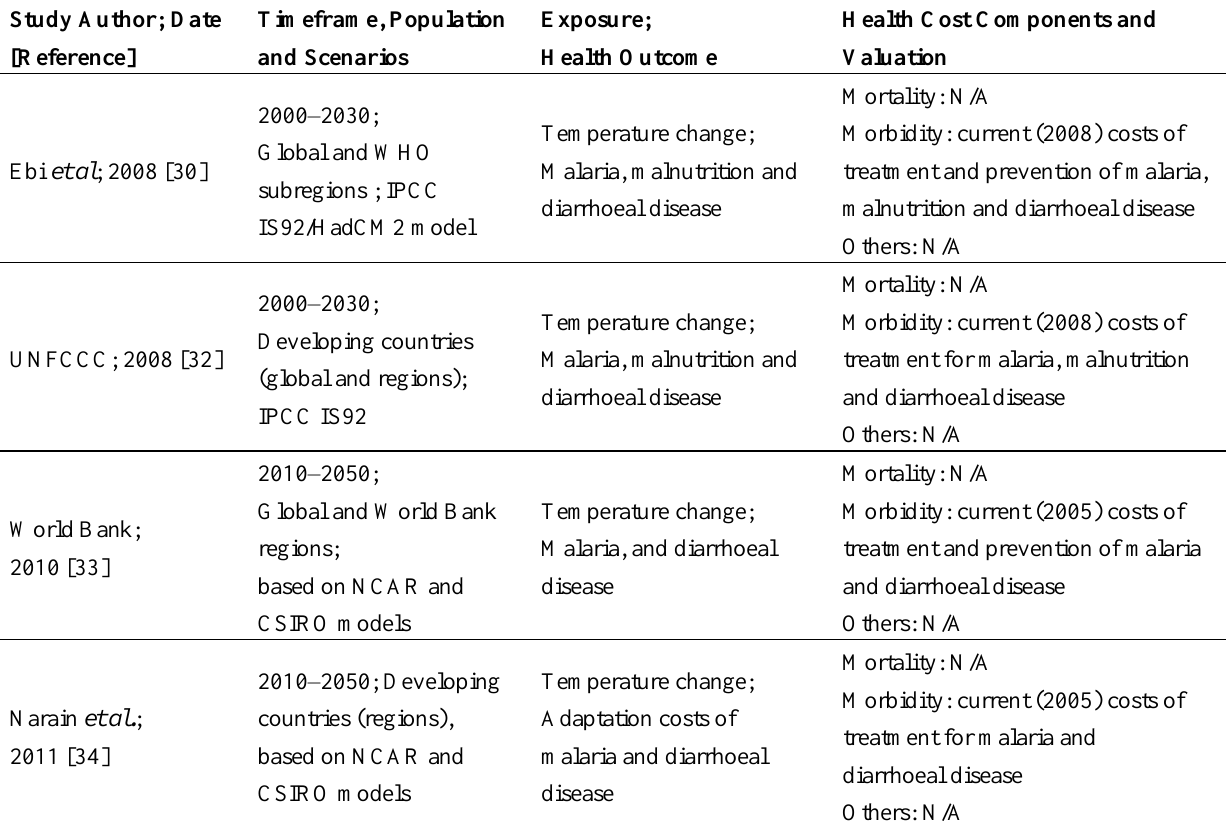
Table 3. Studies estimating aggregated costs of health